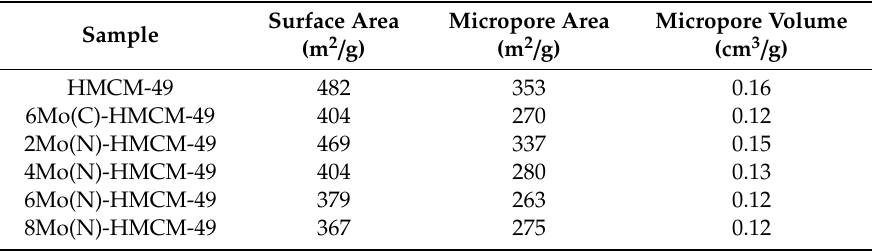
Figure 9. Nitrogen adsorption-desorption isotherms and pore size distributions of ( a ) HMCM-49 and ( b ) 6Mo(N)-MCM-49. Table 2. Textural properties of HMCM-49, 6Mo(C)-HMCM-49, and HMCM-49 modified with different contents of nano-MoO 3.